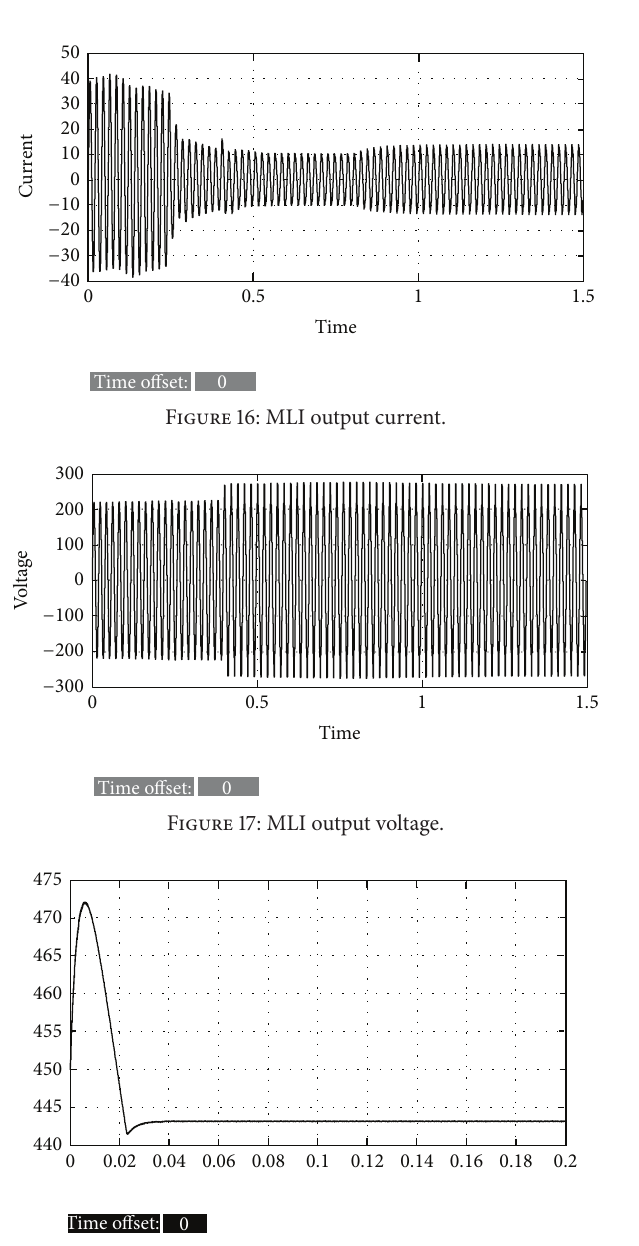
Figure 18: Parallel boost converter output voltage.